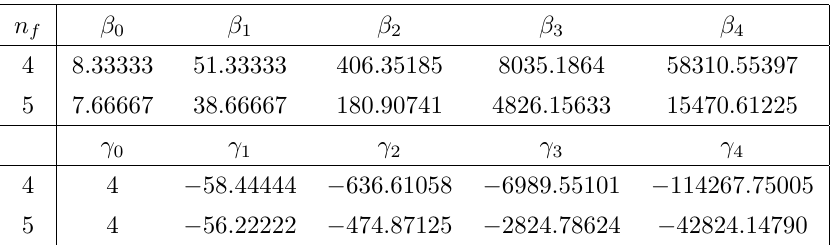
Table 4 . QCD beta function and MS mass anomalous dimension coe(cid:14)cients for n f = 4 (second and (cid:12)fth rows) and n f = 5 (third and last rows), up to (cid:12)ve